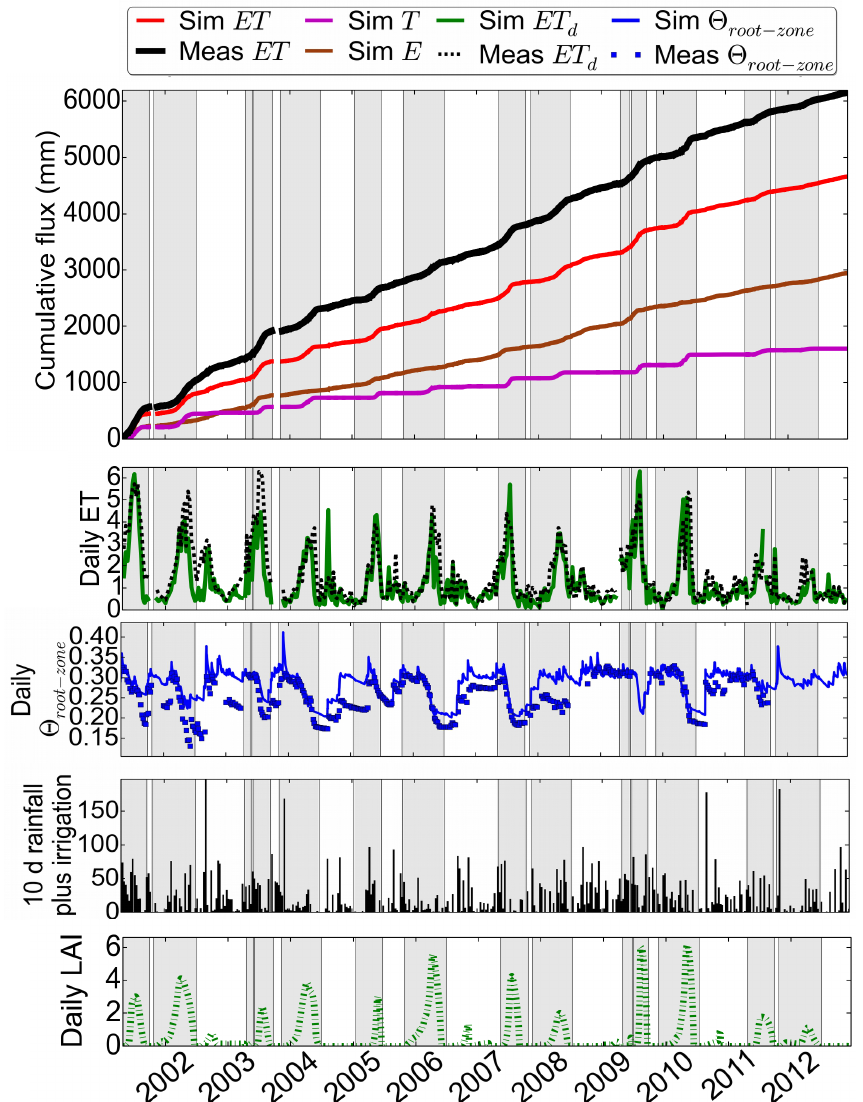
Figure 3. Evolution of simulated and measured evapotranspiration (ET in mm), simulated soil evaporation ( E in mm), simulated plant transpiration ( T in mm), simulated and measured daily daytime ET (ET d in mm), simulated and measured daily mean of root-zone soil moisture ( θ root-zone in m 3 m − 3 ) , 10-day rainfall plus irrigation (in mm), daily mean of in situ LAI (in m 2 m − 2 ) over the 2001–2012 period. For clarity, the average of daily values over 10 days are displayed. The simulation corresponds to the standard implementation of the model (PTF). Crop and inter-crop periods are represented by grey and white backgrounds, respectively. Meas and Sim mean measured and simulated,